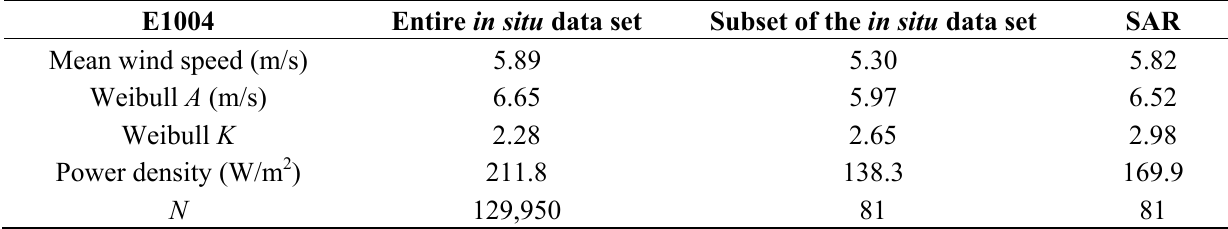
Table 5. Wind energy parameters statistics at E1004 using all meteorological observations and a subset of 81 smples from the in situ data set corresponding to the satellite recording times at 60 m extrapolated to 10 m.